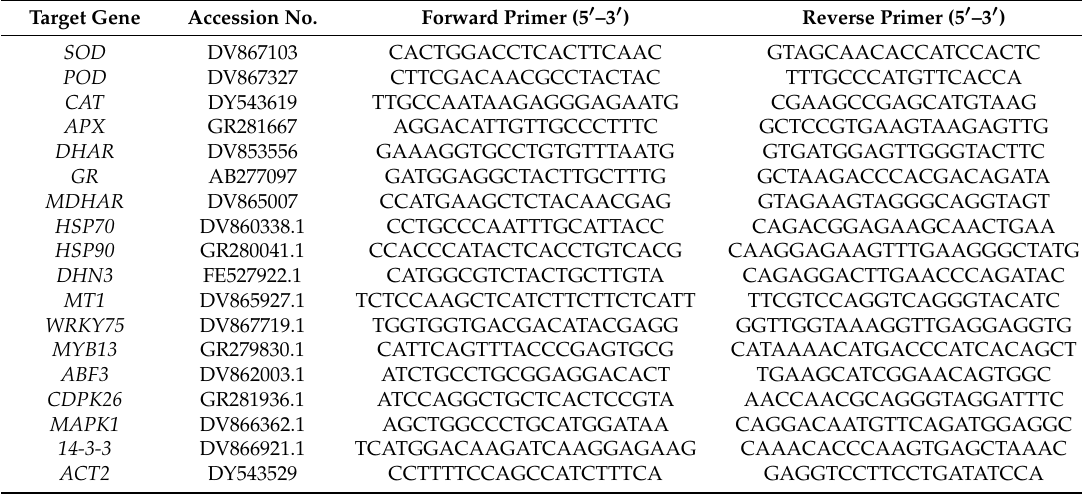
Table 1. Primer sequences used in qRT-PCR and their corresponding GeneBank accession numbers of the analyzed